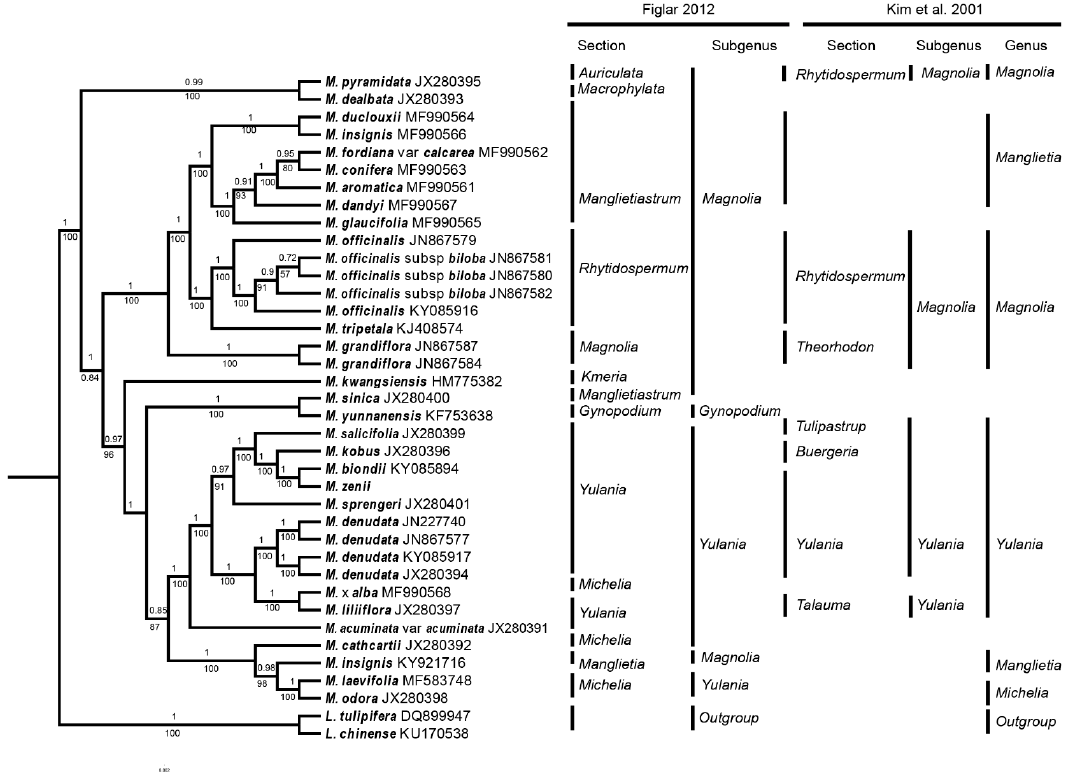
Figure 4. BI phylogenomic tree of 28 Magnolia (represented by 36 individuals) and 2 Liriodendron species. Numbers above the lines indicate the posterior probability of each clade, and numbers below the lines indicate the likelihood bootstrap values. The vertical lines on the right of the phylogenomic tree show the subgeneric taxonomic placement of these species according to Kim et al. [21] and Figlar [64].